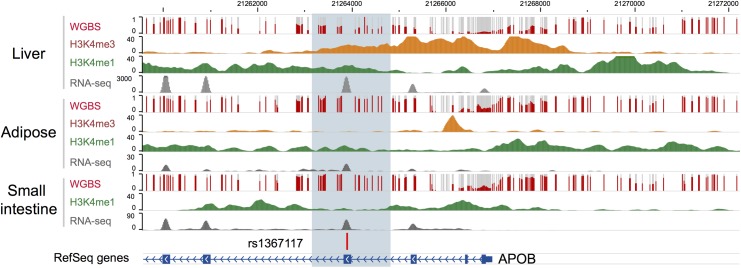
Bioinformatic annotation for the APOB locus.Bioinformatic annotation was undertaken for rs1367117, located within the 4th exon of the APOB gene, using the Epigenome Browser (http://epigenomegateway.wustl.edu/). APOB gene is shown in the blue track and the focal SNP with a vertical bar. Level of DNA methylation (whole genome bisulfite sequencing, or WGBS), histone marks indicative of promoters (H3K4me3) and enhancers (H3K4me1), and expression levels (RNA-seq) were plotted in three relevant tissues: liver, adipose, and small intestine.